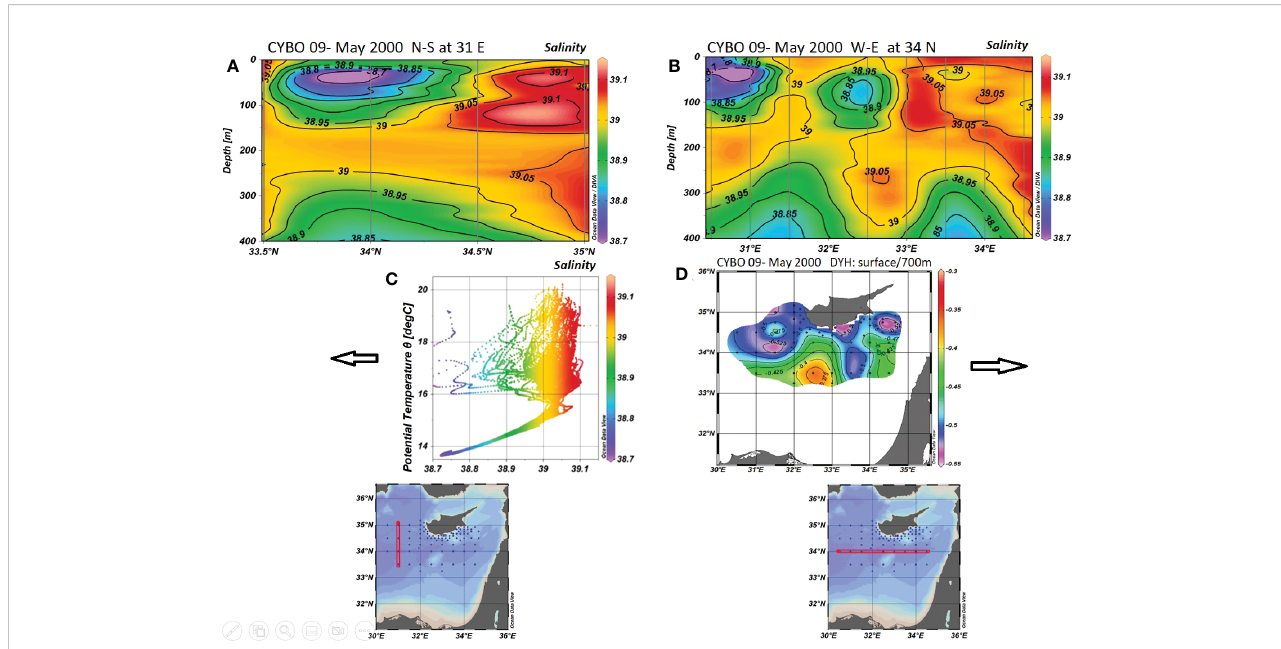
FIGURE 3 Results from CYBO 09 (May 2000): (A) N-S section along 31°E, (B) W-E section along 34°N, (C) T/S diagram, and (D) dynamic height topography relative to 700